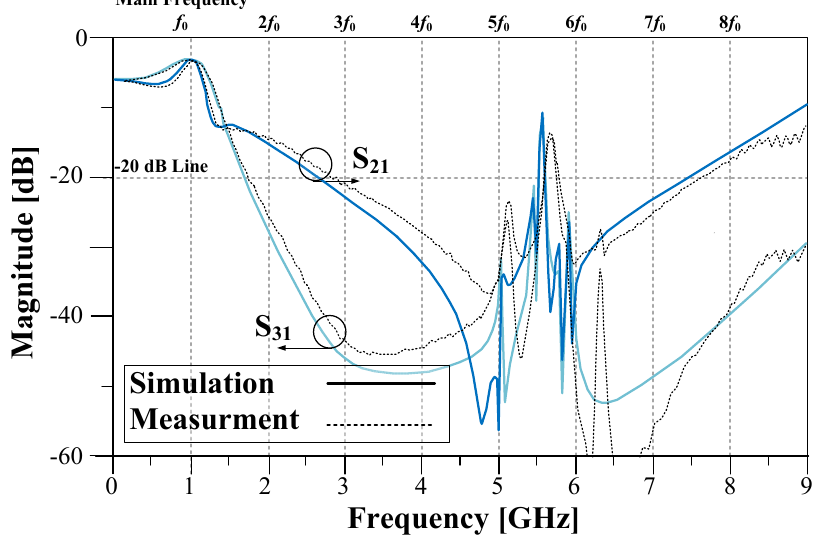
Figure 14. Measured and simulated S 21 and S 31 parameters of the proposed BLC.